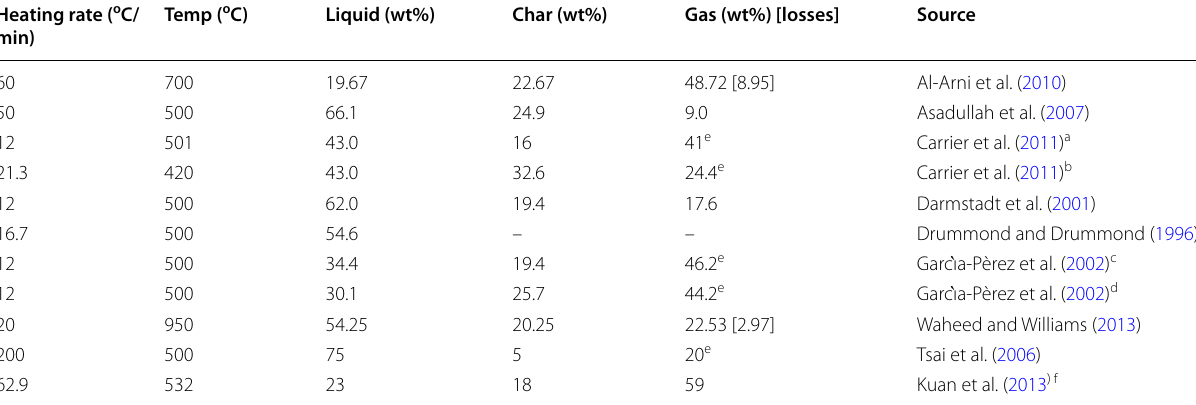
a Slow pyrolysis, b vacuum pyrolysis, c laboratory-scale setup, d pilot-scale setup, e estimated by difference, f non-catalysed process